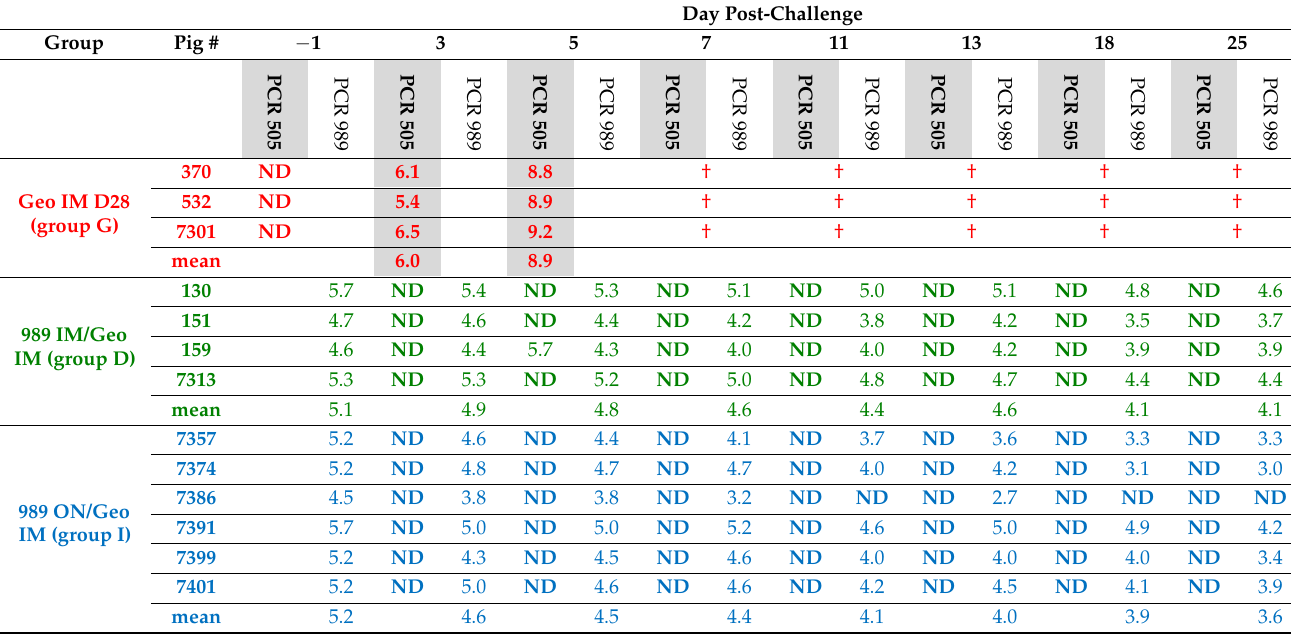
Table 2. Detection of ASFV-989 and Georgia viremia after IM Georgia strain challenge of immunized or nonimmunized pigs (D28 PI).